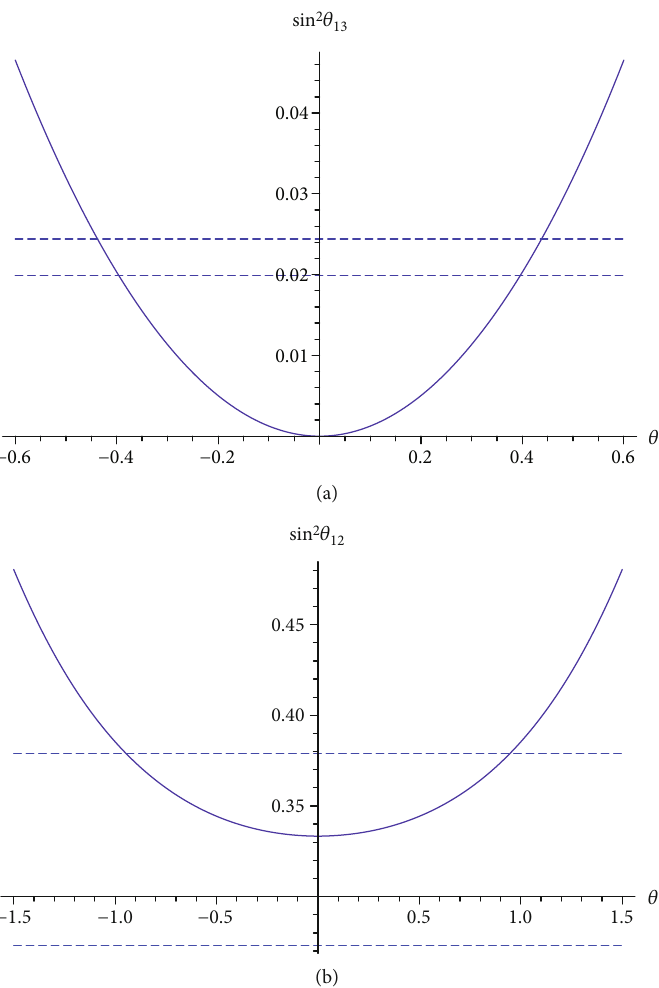
Figure 1: Dependence of functions sin 2 θ from the recent global fi t [51]. For sin 2 θ